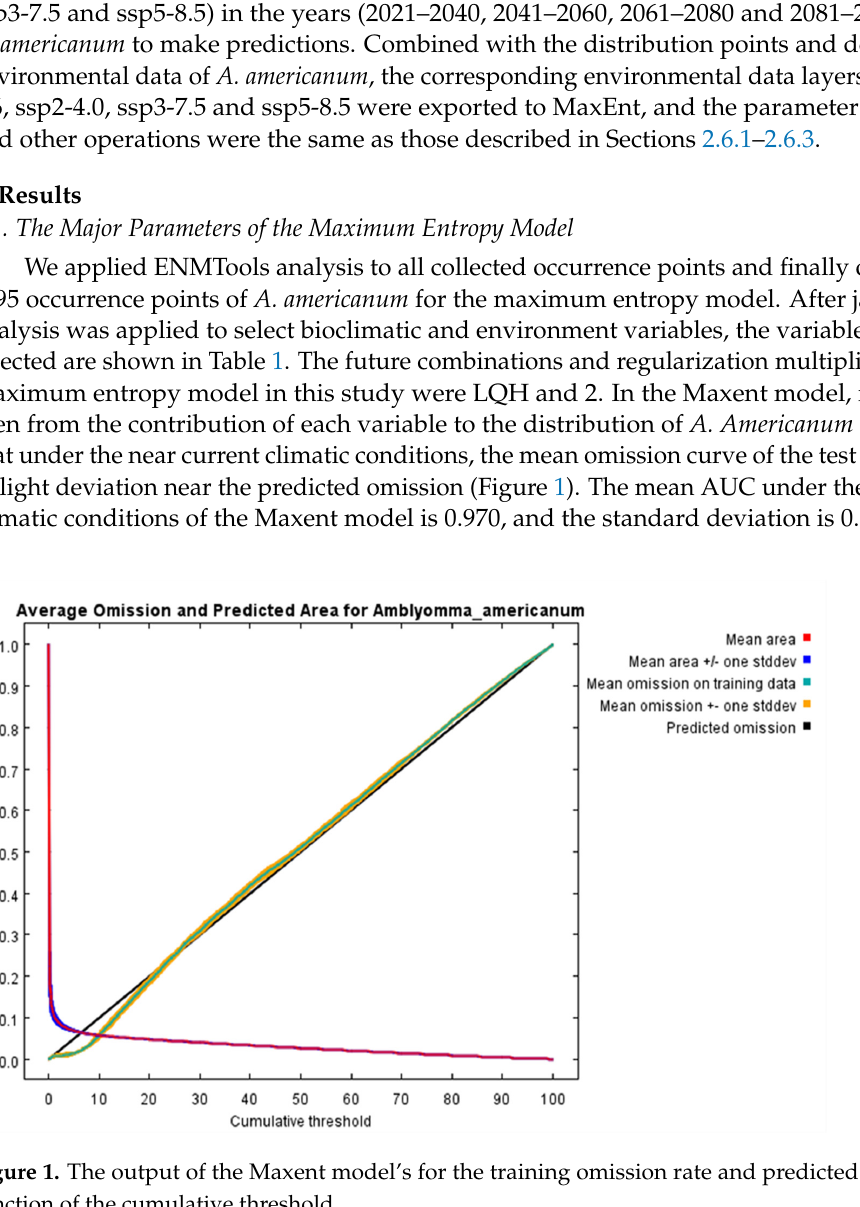
Figure 2. Current occurrence and global distribution of A. americanum.